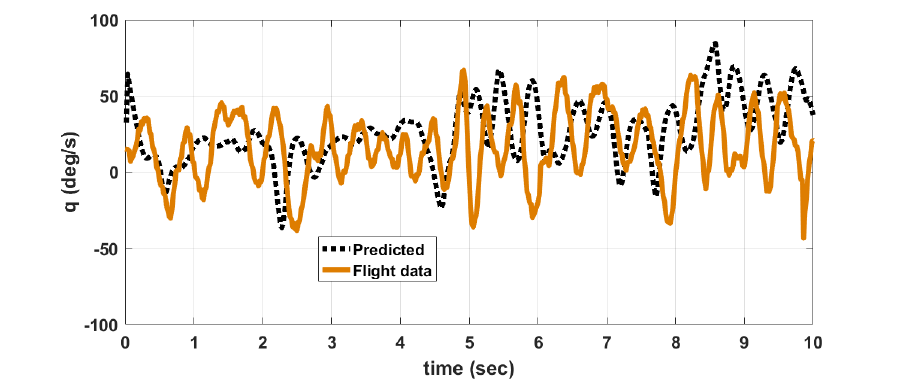
Figure 17. Comparison of angular rate q , predicted by model and flight data.